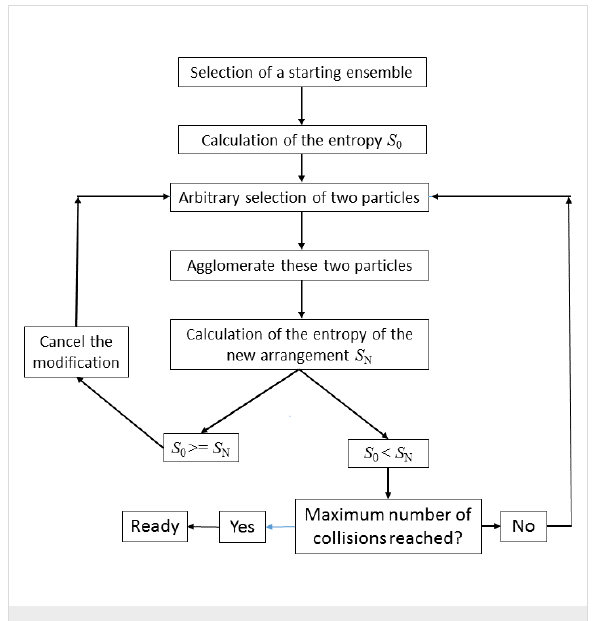
Figure 1: Flow chart of the algorithm to calculate the agglomeration of an ensemble in the direction of a maximum entropy.